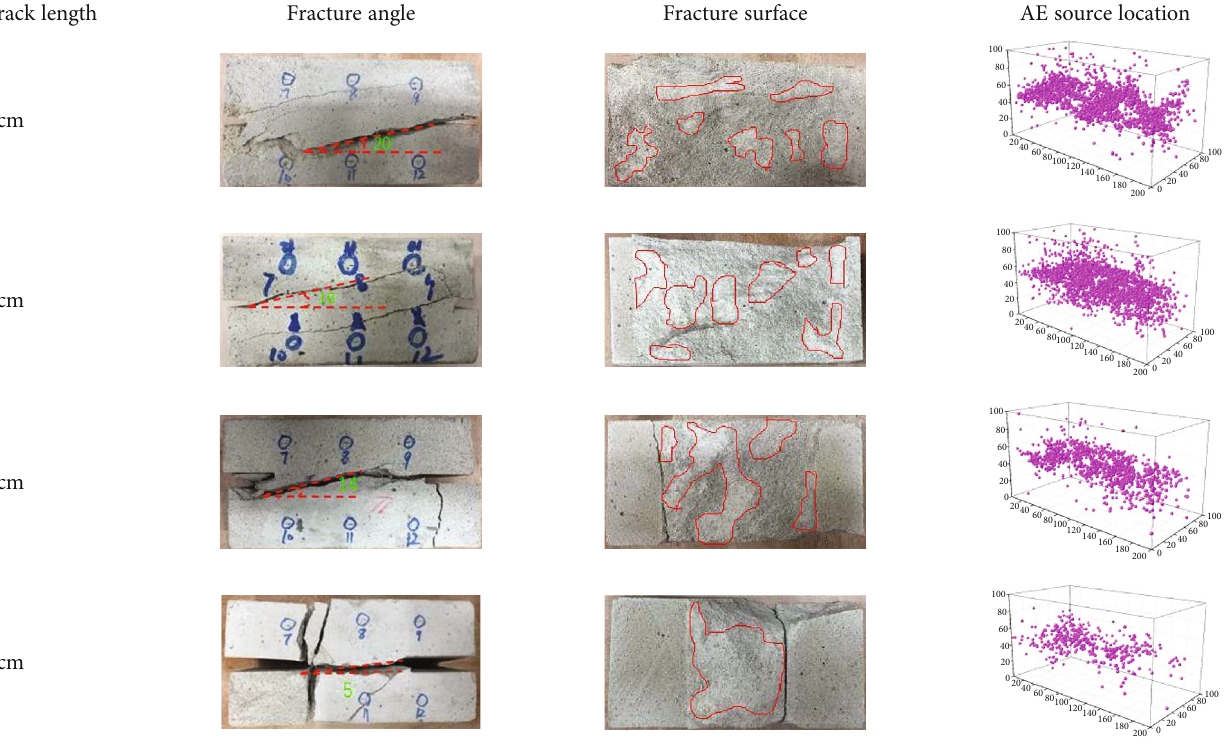
Table 4: Failure mode of specimens with di ff erent bilateral